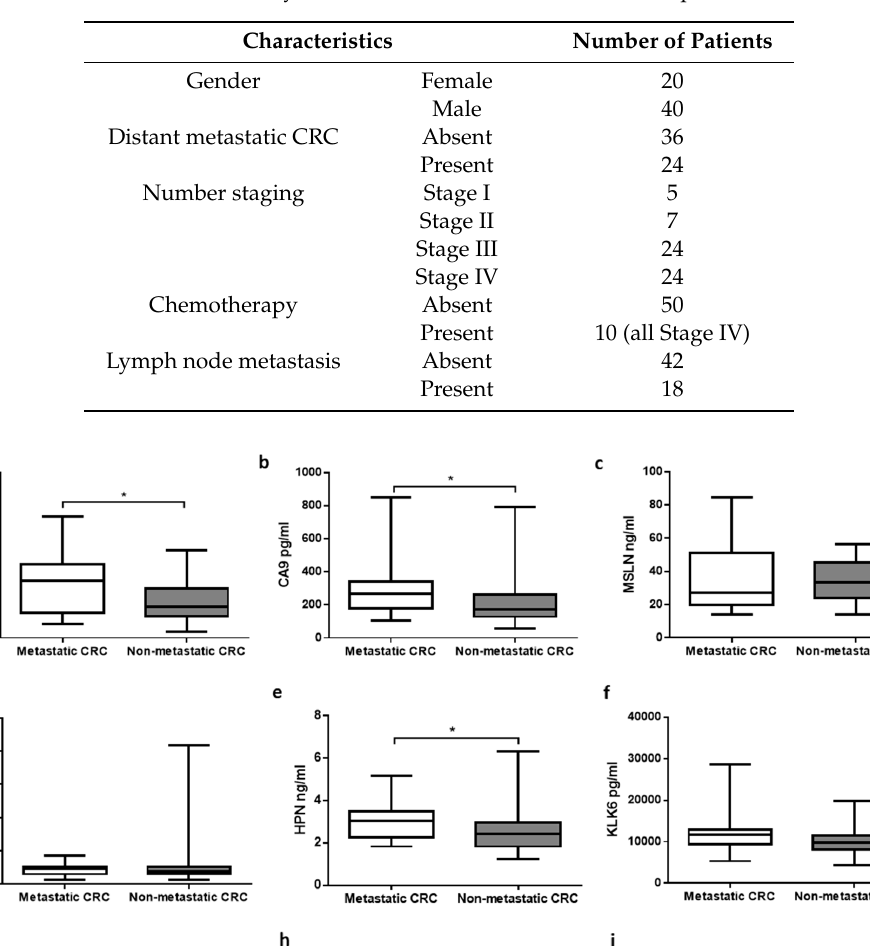
Table 3. Summary of characteristics of the included CRC patients.